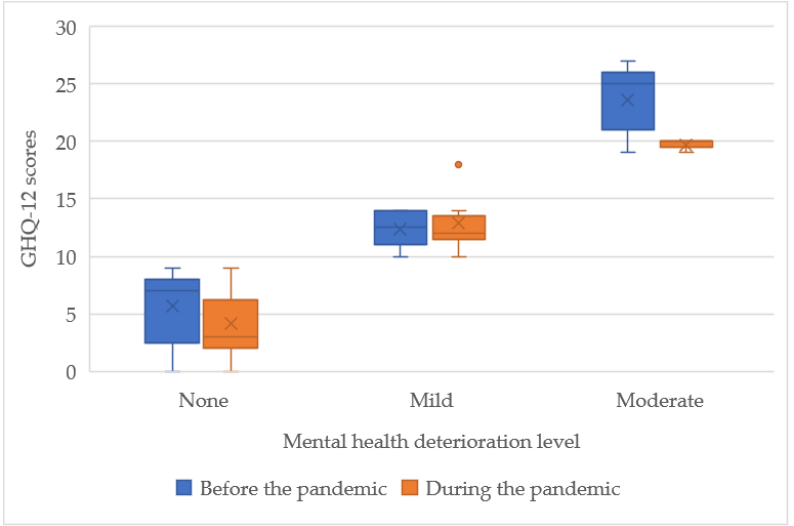
Figure 2. Interquartile range of the GHQ-12 scores of the studied groups.